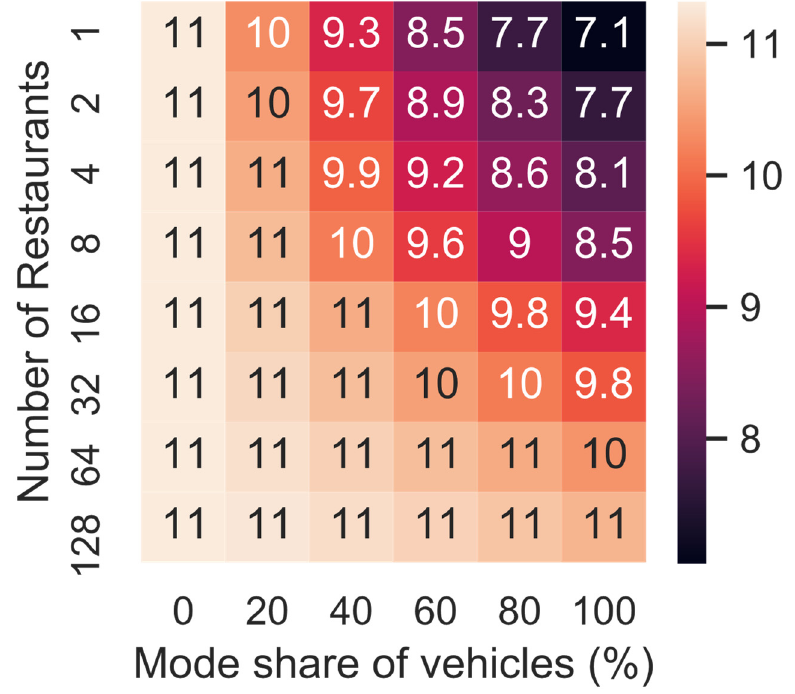
Figure 7. Average speed for varying mode share and number of restaurants.